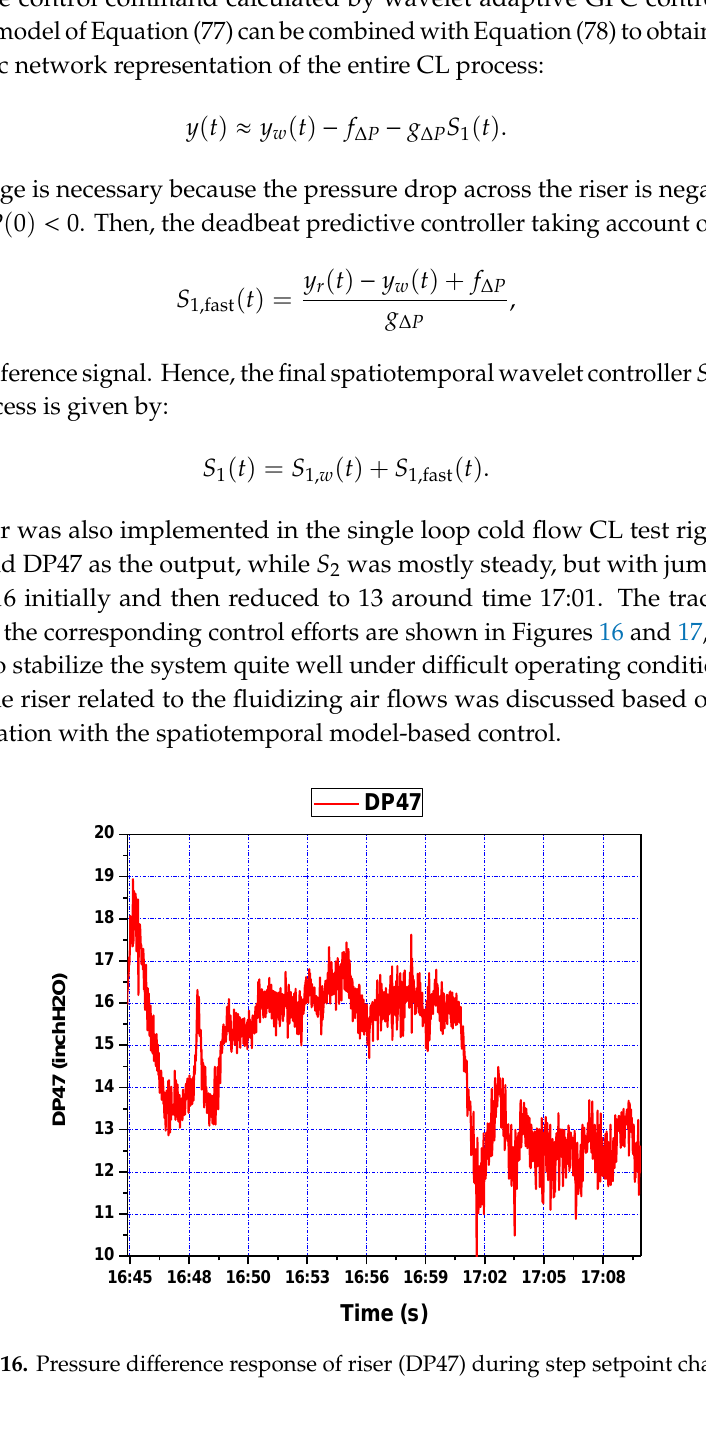
Figure 17. Fluidizing air flow control (S1 and S2) during setpoint changes. 5. Discussion The control objective of developing the tracking controller for the CL test rig at ALSTOM Power was addressed at the start of the project through both first-principles model development and empirical system identification from the input/output experimental data record. The first approach resulted in the analytical development and the numerical simulation of the 1D, 2D, and 3D partial